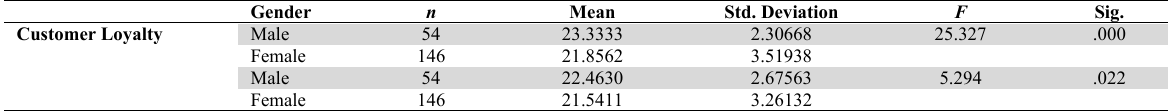
Gender Differences in Customer Satisfaction and Customer Loyalty